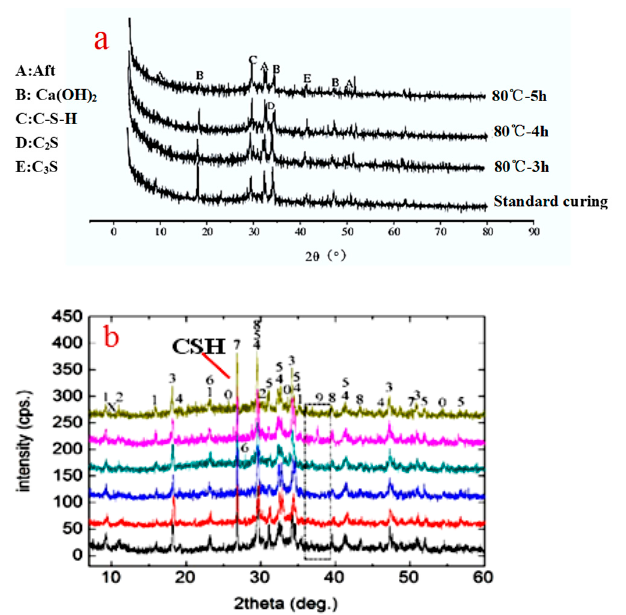
Figure 7. XRD spectra of different curing systems: ( a ) different curing time ( b ) Different curing temperatures [57,58].